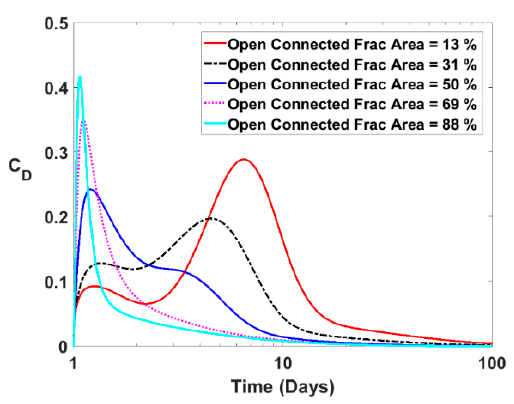
Figure 23. Impact of open connected (F OC ) fracture area on tracer response curves.